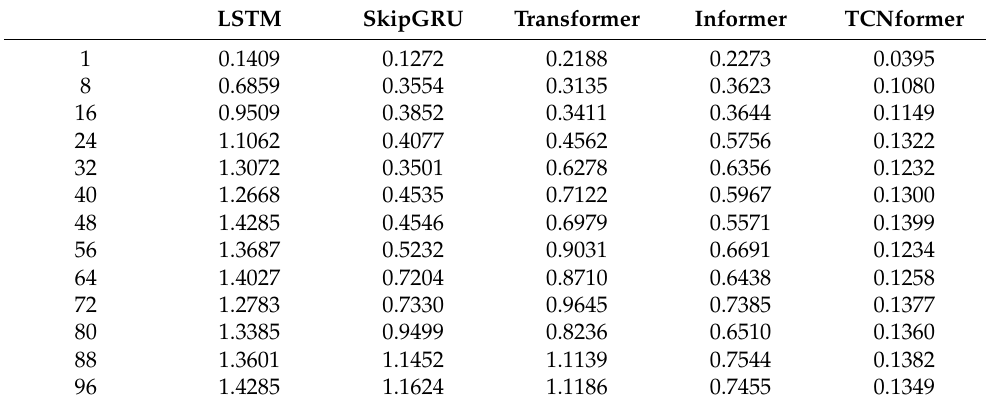
Table 4. Prediction Accuracy (MSE) Results of periodicity analysis.